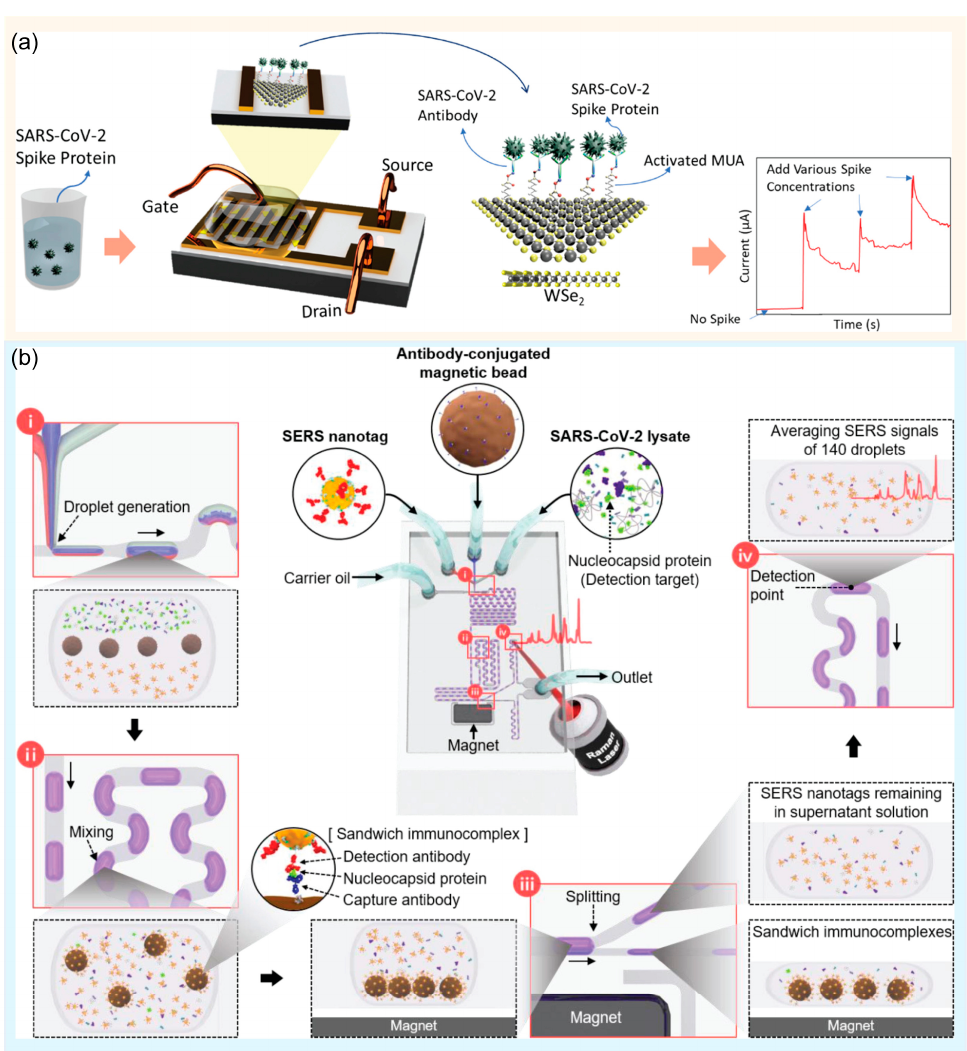
Figure 4. ( a ) Schematic representation of the FET-based biosensor for the rapid and sensitive detection of SARS-CoV-2 in vitro. Reprinted with permission from [68]. Copyright (2022) ACS publications. ( b ) Schematic representation of the microdroplet SERS sensor for the immunodiagnostic test of SARS-CoV-2. (i) Droplet generation. (ii) Droplet mixing. (iii) Droplet splitting. (iv) Optical signal measurement. Reprinted with permission from [69]. Copyright (2022) Elsevier.